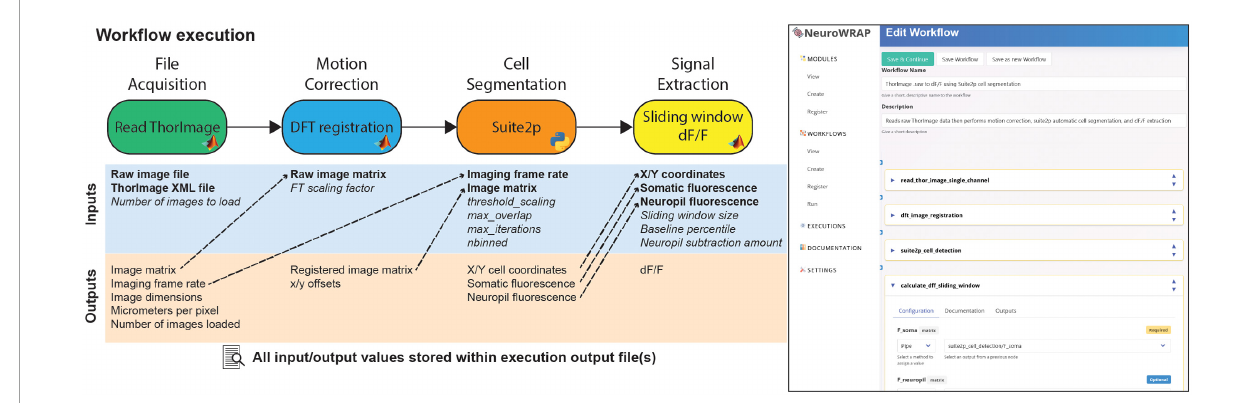
FIGURE2 Example workflow execution. An analysis workflow featuring 4 modules. Below each module are its input and output variables, where required inputs are bolded and optional inputs are italicized. Dashed arrows represent output variables that have been piped as inputs to downstream modules. All pictured information is stored in the output file upon execution of this workflow. On the right, a screenshot of the NeuroWRAP GUI is shown illustrating the setup page for this specific workflow.